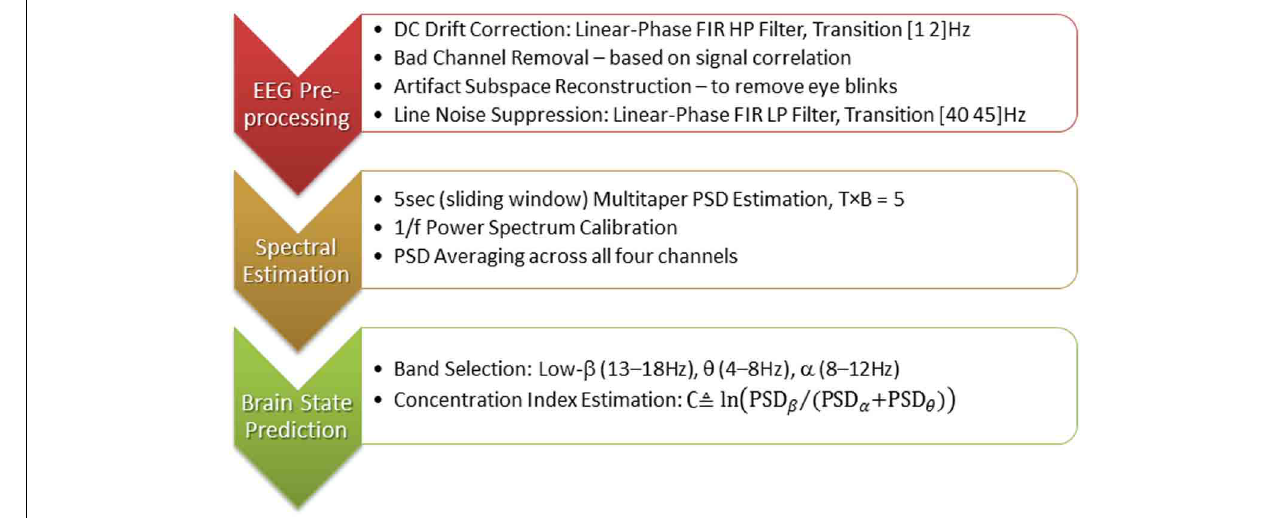
FIGURE 8 | Brain state estimation pipeline used in EEG Tractor Beam game.